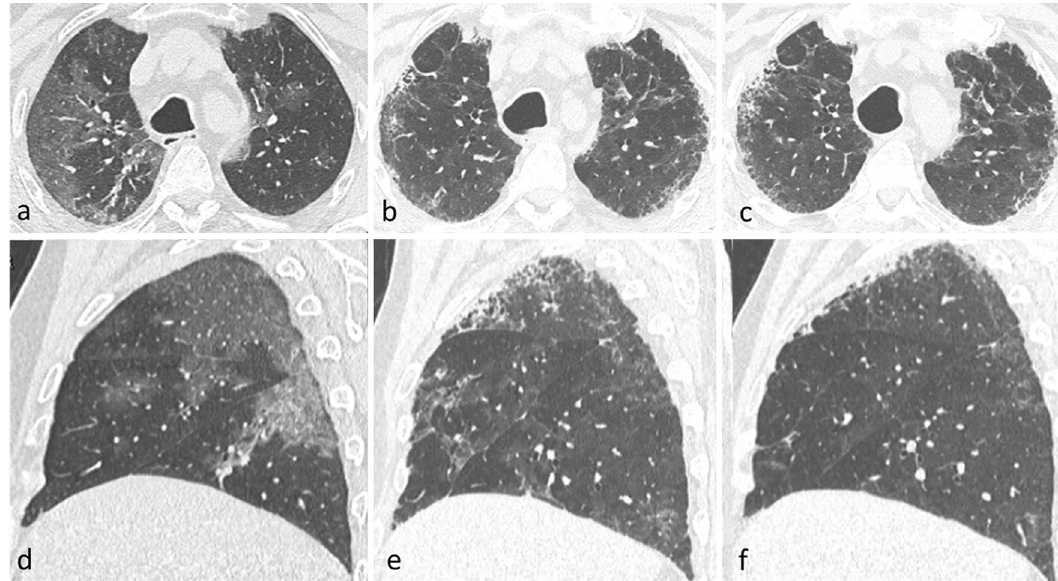
Figure 4. Disease evolution pattern consistent with fibrotic abnormalities (Non-Specific Interstitial Pneumonia, NSIP pattern). Axial ( a – c ) and sagittal ( d – f ) CT images showing patchy ground glass opacities at baseline ( a – d ), subtle residual ground-glass opacities, and appearance of subpleural reticulation and traction bronchiectasis in upper lobes at 2–3 months ( b – e ) and at 6–7 months ( c – f ).